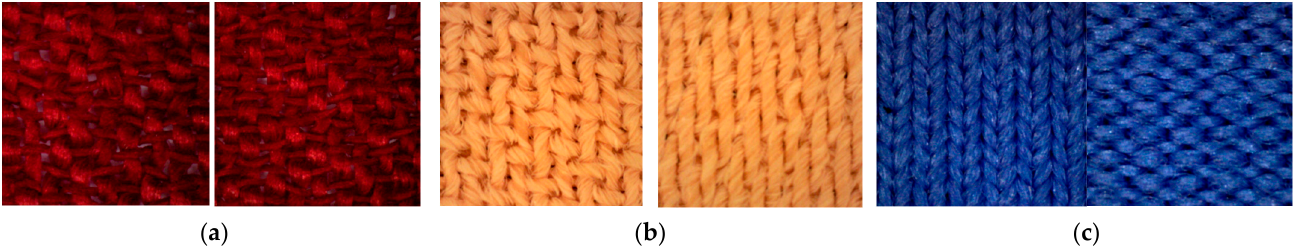
Figure 1. Images of three specimens with different fabric constructions taken by an image analyzer. ( a ) Plain-woven fabric; ( b ) twill-woven fabric; and ( c ) plain knit.